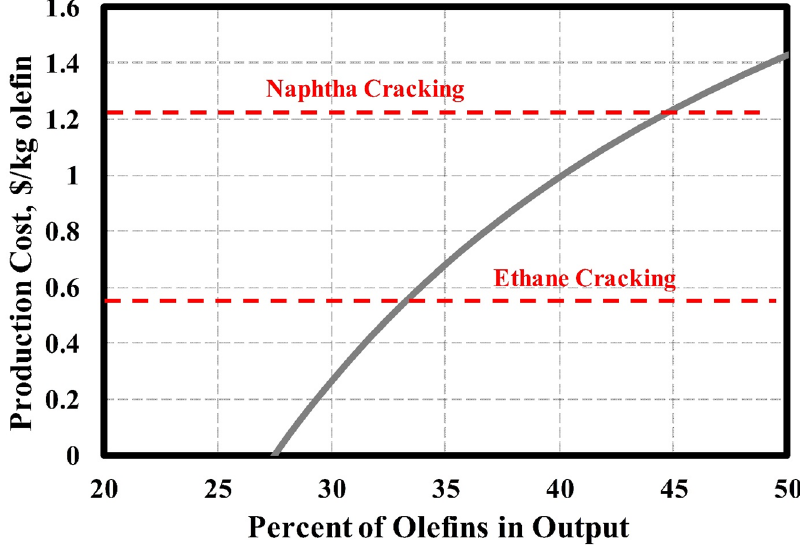
Figure 3. Sensitivity analysis of olefin production cost as a function of olefin production ratio (Fayetteville shale gas).